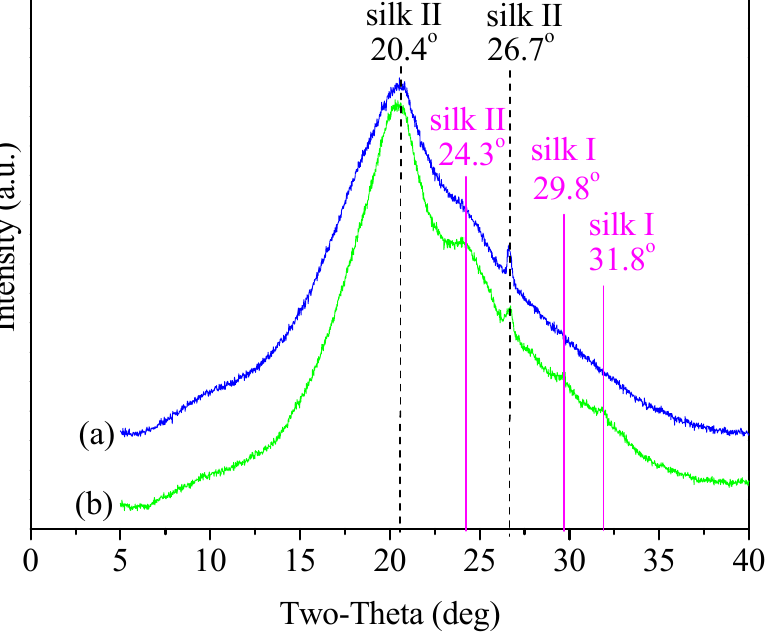
Figure 3. XRD spectra of ( a ) SF and ( b ) SSF.